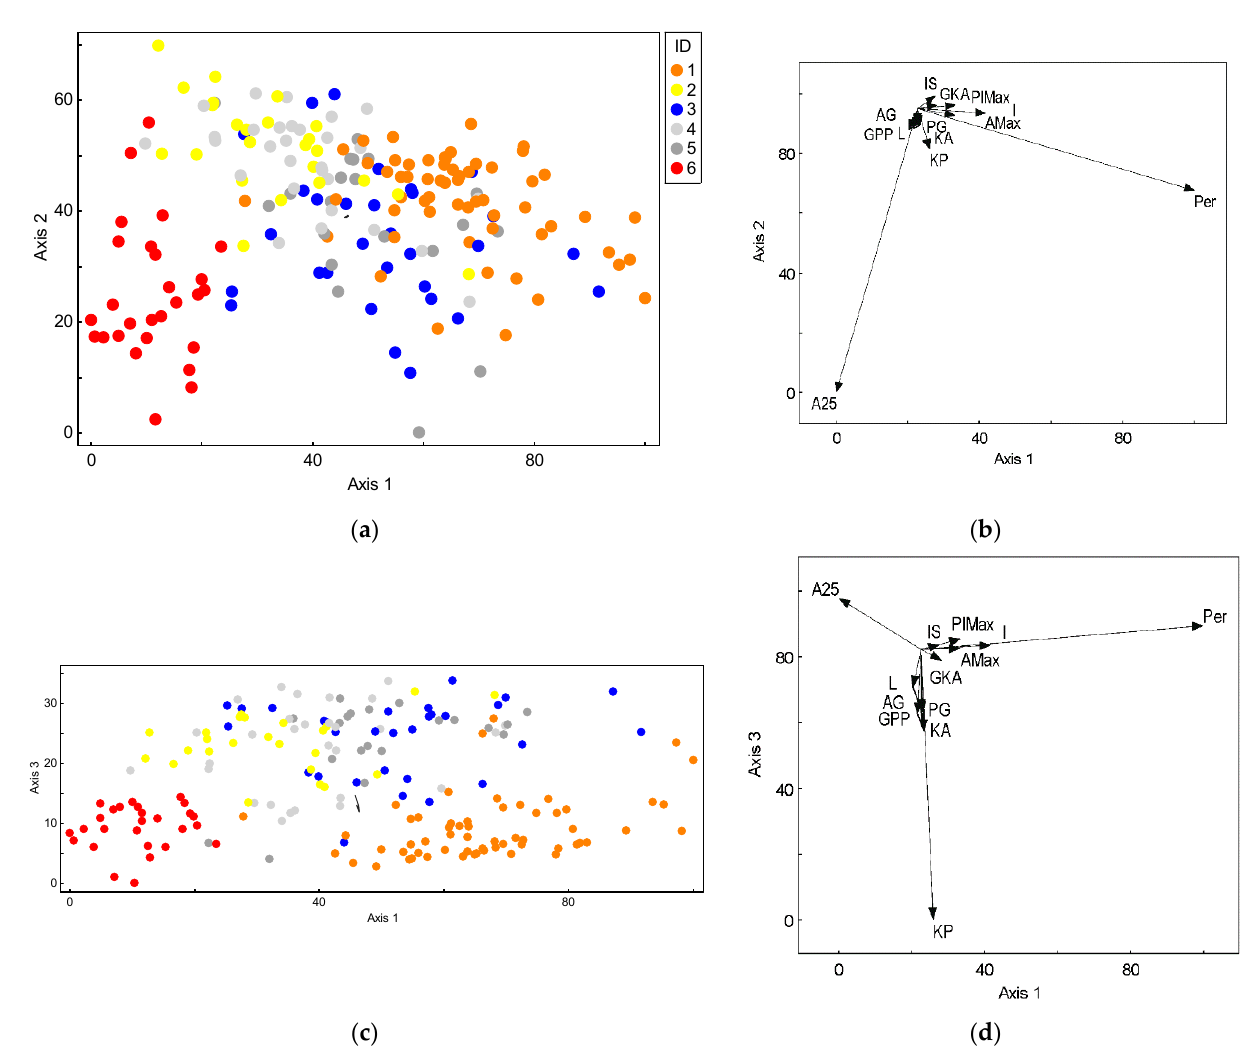
Figure 3. Ordination plots (PCAs) of 13 leaf morphology traits of elm species. ( a ) Distribution of trees on axes 1 and 2; ( b ) vectors of tree leaf morphological characteristics on axes 1 and 2. ( c ) Distribution of trees on axes 1 and 3; ( d ) vectors of tree leaf morphological characteristics on axes 1 and 3. Dashes indicate the spatial arrangement of vectors. Species ID: 1: U. glabra ; 2; U. minor ; 3: U. glabra × U. minor ; 4: U. minor subsp . minor Richens; 5: U. minor subsp . minor × U. glabra ; and 6: U. laevis . Morphological leaf characteristics: Per—perimeter; I—the blade length; PlMax—the blade maximum width; AMax—the distance from the base to the point of maximum blade width; A25—the asymmetry at 25% blade length; PG— the main vein pubescence; AG—the pubescence of secondary veins; L—the blade pubescens; IS—the secondary vein stretch; GKA—the secondary vein angle pubescence; KA—the upper petiole half pubescence; KP—the petiole upper half pubescens; and GPP—the main vein pubescens type.